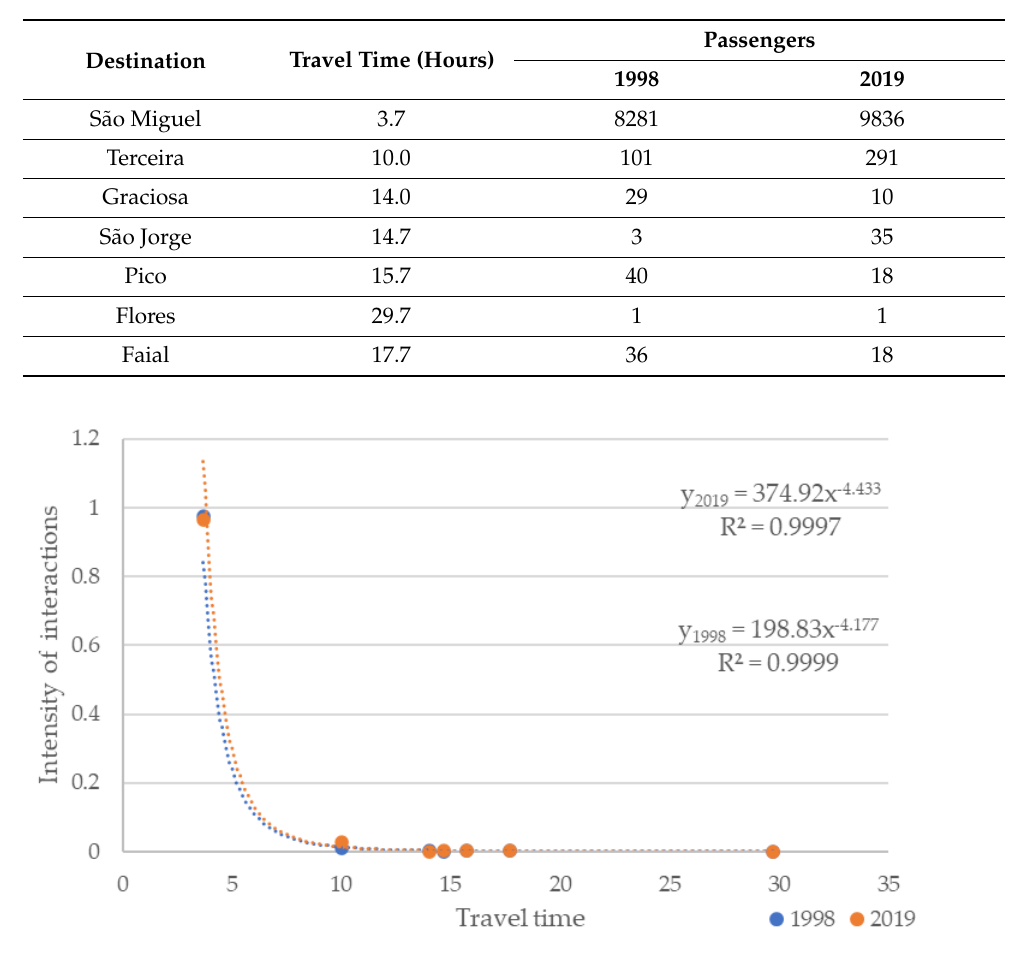
Figure 9. Intensity of interactions and travel time to Santa Maria Island from the rest of the archi- pelago — for 1998 and 2019. archipelago—for 1998 and